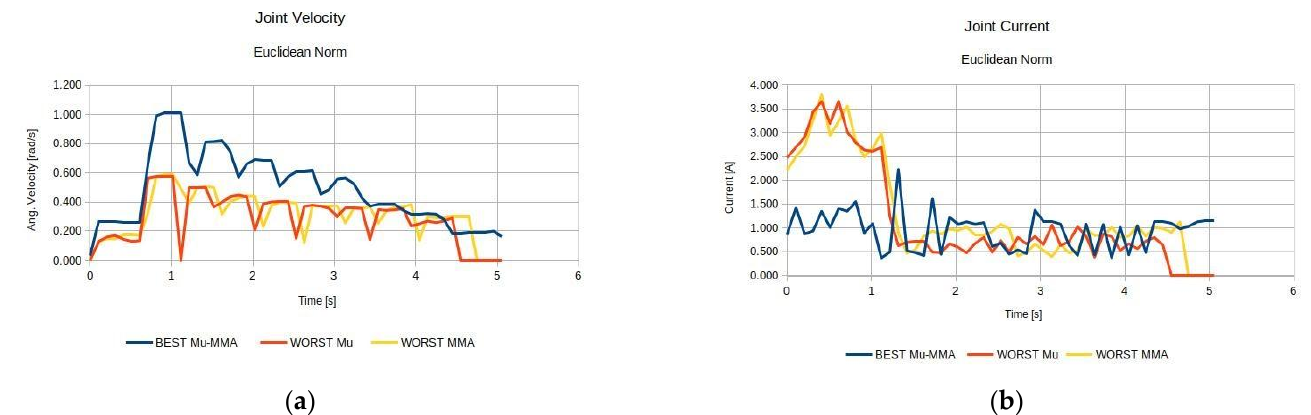
Figure 16. Comparison of the required joint velocities ( a ) and joint current usage ( b ) for the best anatomy and the worst performing anatomy under the MMA and effective mass performance index for Task 2.